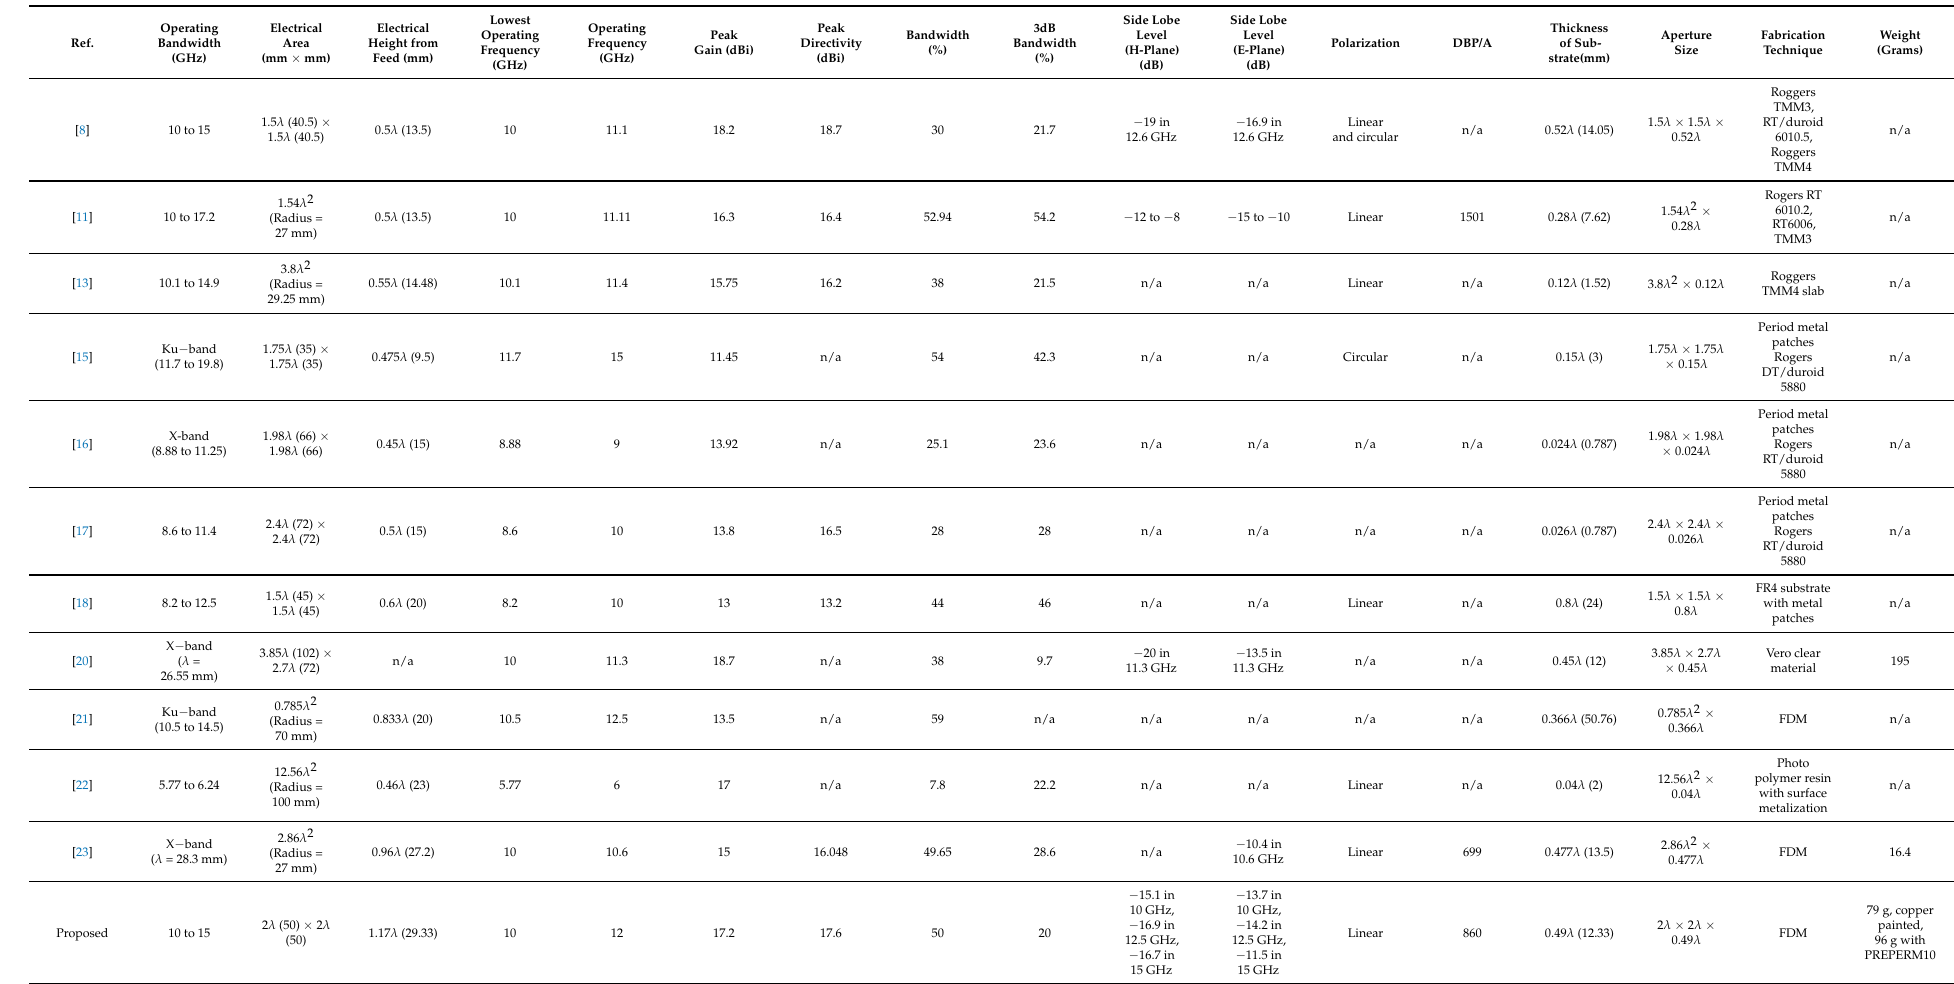
Table 1. Comparison of the proposed wideband prototypes against the available antenna structures.